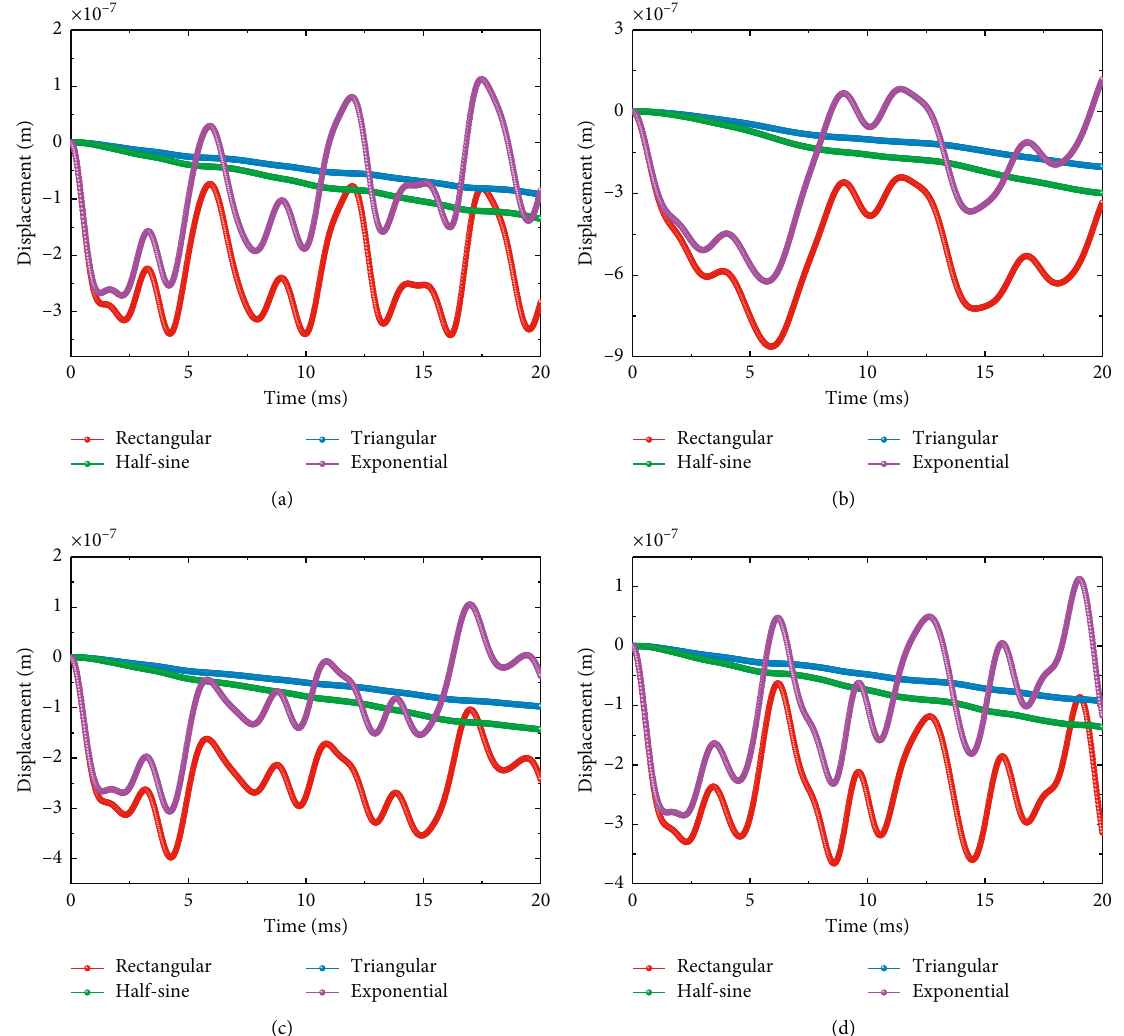
Figure 17: The displacement response of multi-stepped FG-CNTRC with various boundary conditions. (a) CCCC. (b) SSSS. (c) CCFF. (d) E 1 E 1